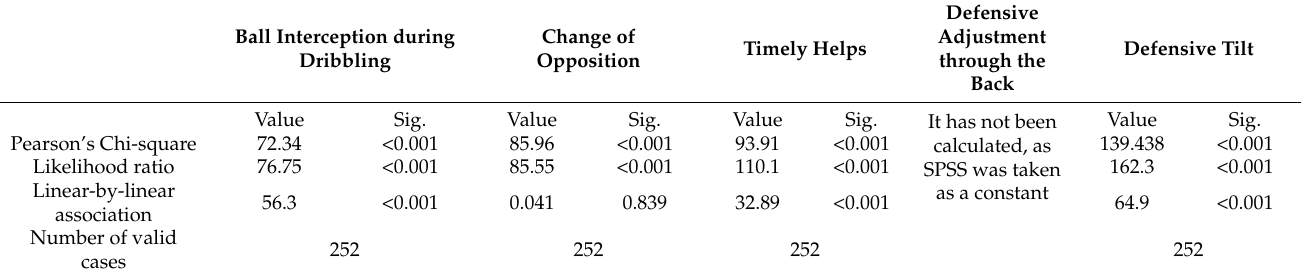
Table 5. Frequency Table and Chi-Square Test